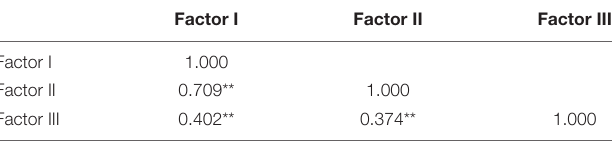
TABLE 3 | Correlations between the ACIPS factors.